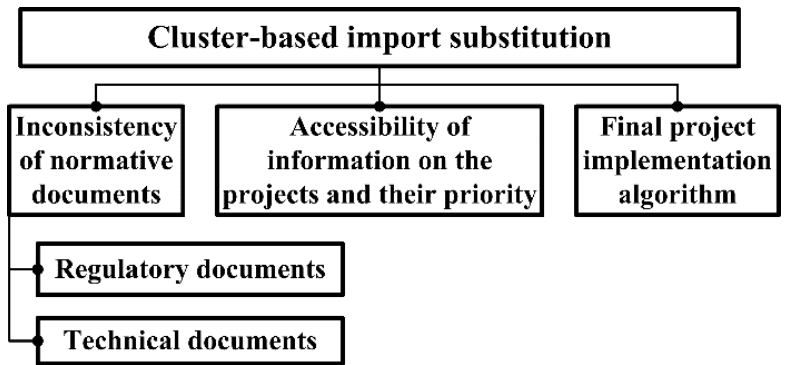
Figure 1. The problems of import substitution